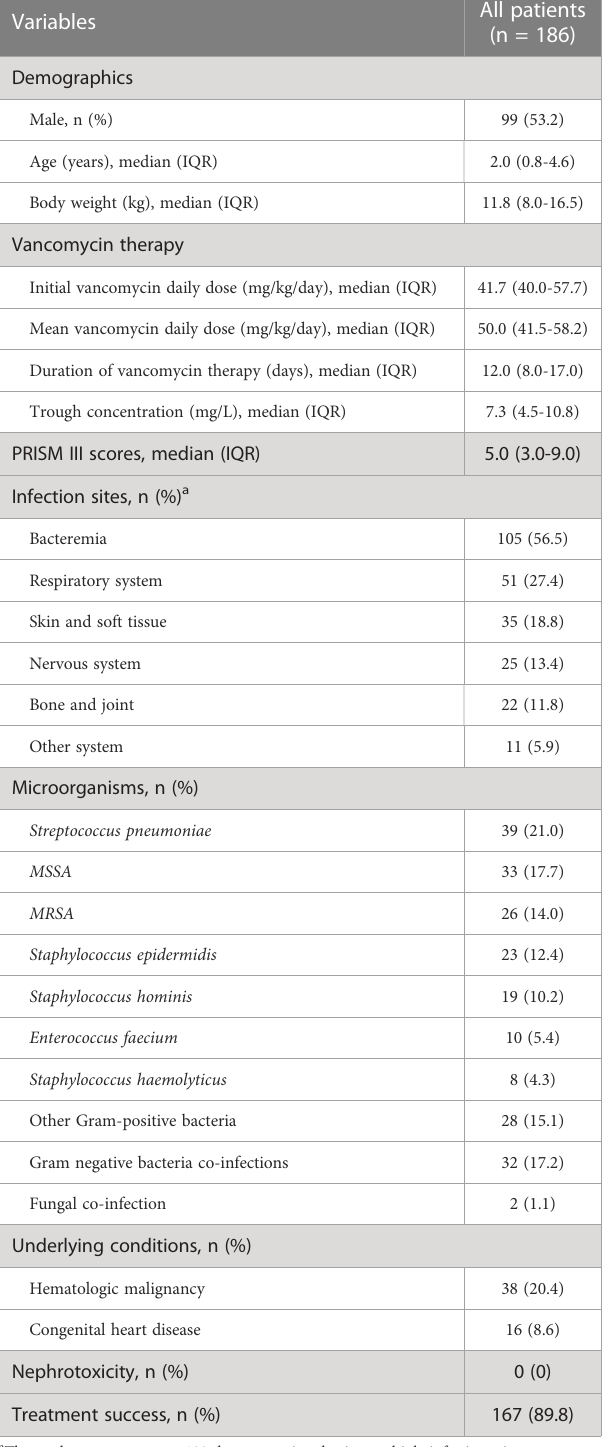
TABLE 1 Basic characteristics and demographic data of all enrolled patients.